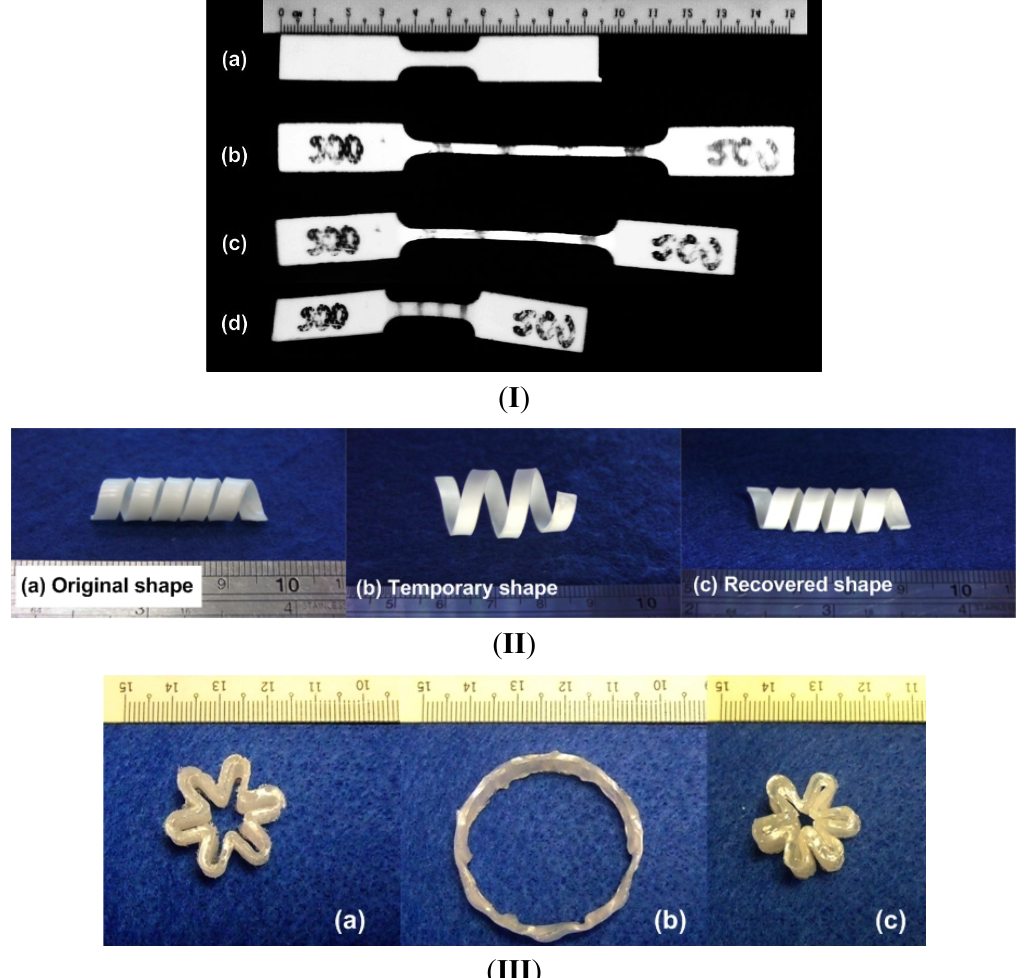
Figure 1. Thermally induced SME in PTFE ( I ), PLA ( II ) and EVA ( III ). ( II and III : reproduced with permission from [3]. Copyright 2012 Springer). ( I ) PTFE: ( a ) original shape; ( b ) after stretching at room temperature; and ( c – d ) after gradually heating to 340 °C in two steps (above the glass transition temperature and at the melting temperature). ( II ) PLA: ( a ) original shape; ( b ) after expansion at high temperatures; and ( c ) after heating for shape recovery. ( III ) EVA: ( a ) original star shape; ( b ) after expansion into circular shape at high temperatures; and ( c ) after heating for shape